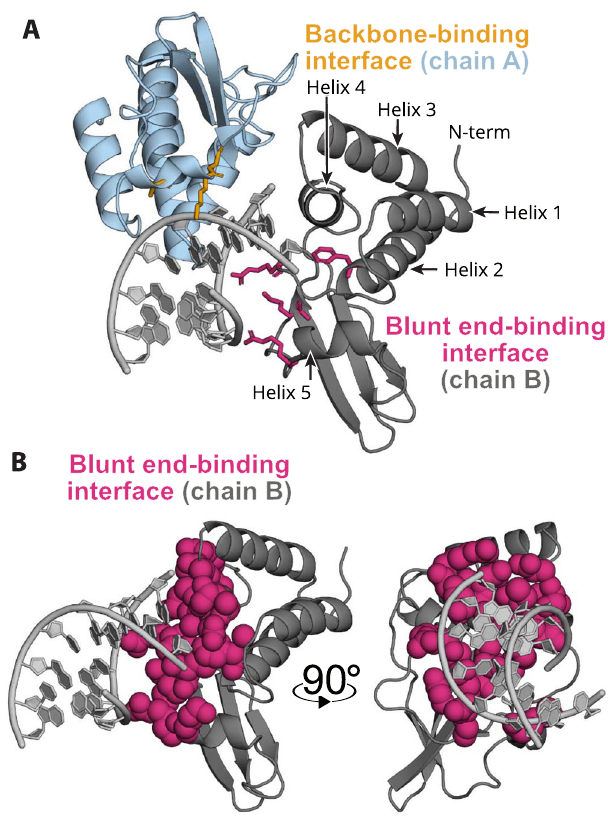
Fig. 1 VP35 dsRNA interactions occur primarily through fl at